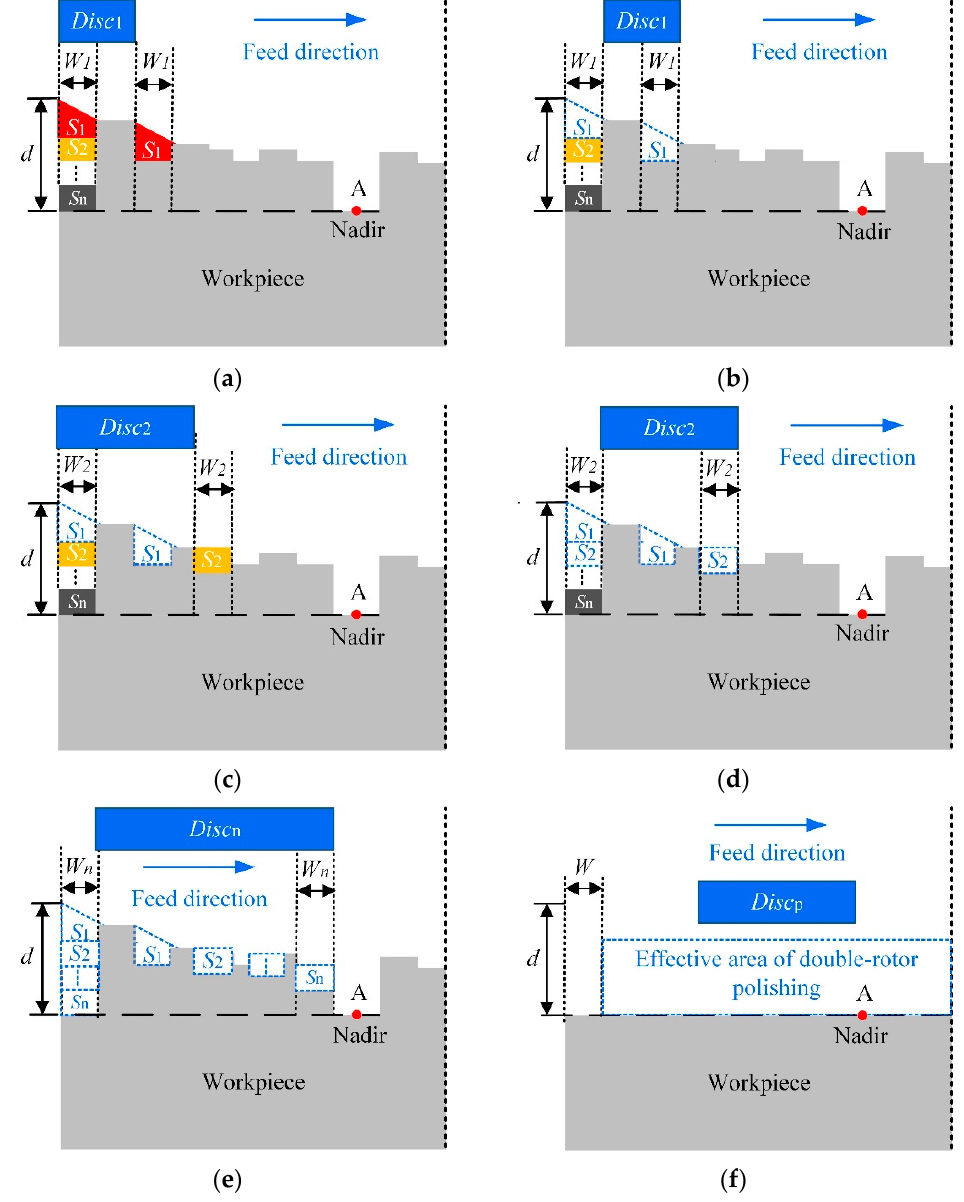
Figure 5. Edge removal theory of the combined polishing. ( a ) initial surface profile, ( b ) surface profile after the first spin-polishing, ( c ) surface contours before the second spin-polishing, ( d ) surface profile after the second spin-polishing, ( e ) surface profile after the n-th spin-polishing, ( f ) surface profile after the double-rotor